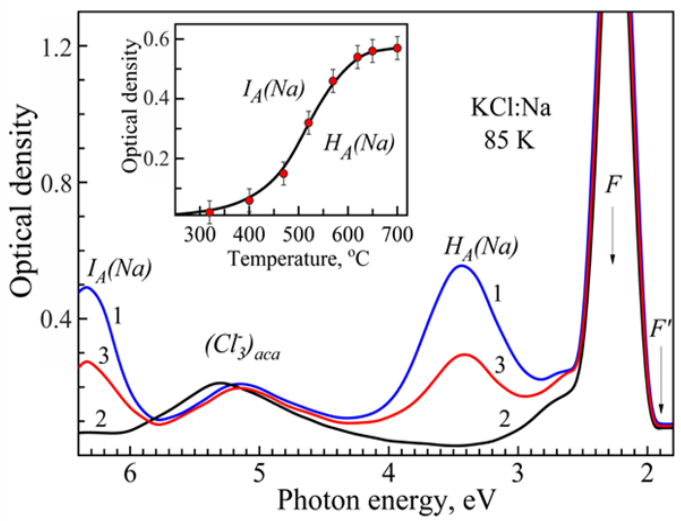
Figure 3. Absorption spectra measured for KCl:Na (1000 ppm) crystals exposed to isodose irradiation by X-rays at 85 K (20 mA, 45 kV, W-anticathode, 3 h). Curve 1—a freshly grown crystal; 2—a similar sample after 3–4 months of storage at RT; 3—after the annealing of a long-stored sample at 600 °C for 15 min. All spectra were measured at 85 K. The insert shows the dependence of the I A (Na) and H A (Na) center concentrations (via relevant absorption bands), induced by an isodose X-ray radiation (3 h) in the annealed crystals, on the quenching temperature.